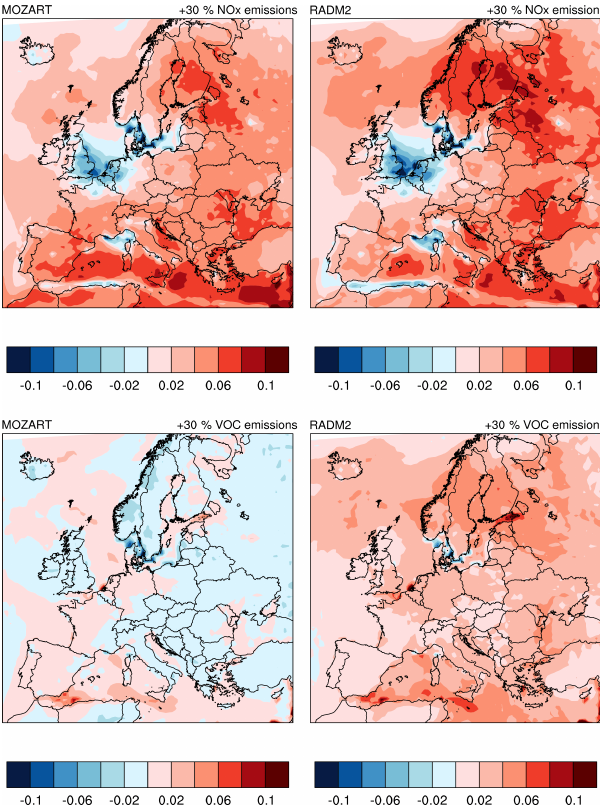
Figure 16. Sensitivity of average surface O 3 for July 2007 to a 30% increase in emissions of NO x (upper row) or VOC (lower row), shown for the MOZART and RADM2 chemical mecha- nisms. Shown here is the percent change in O 3 concentration, i.e., 100 × ( [ O 3 ] + 30% emissions −[ O 3 ] base )/ [ O 3 ] base